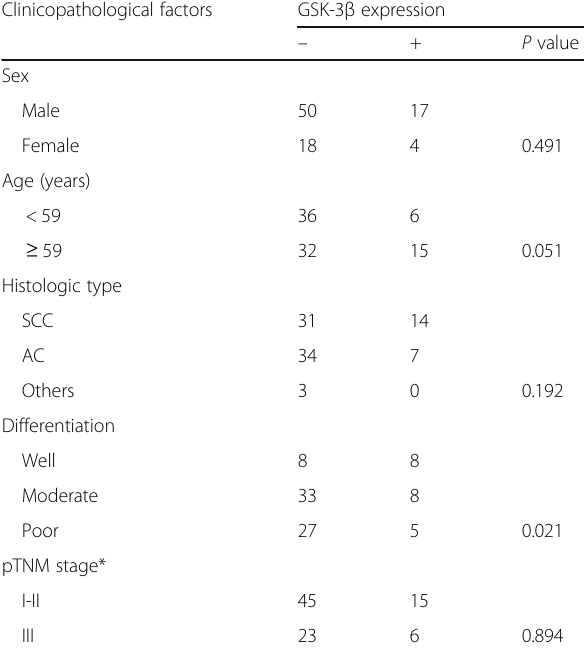
Table 1 Correlation of GSK-3 β expression with the clinicopathological features of 89 NSCLC patients Clinicopathological